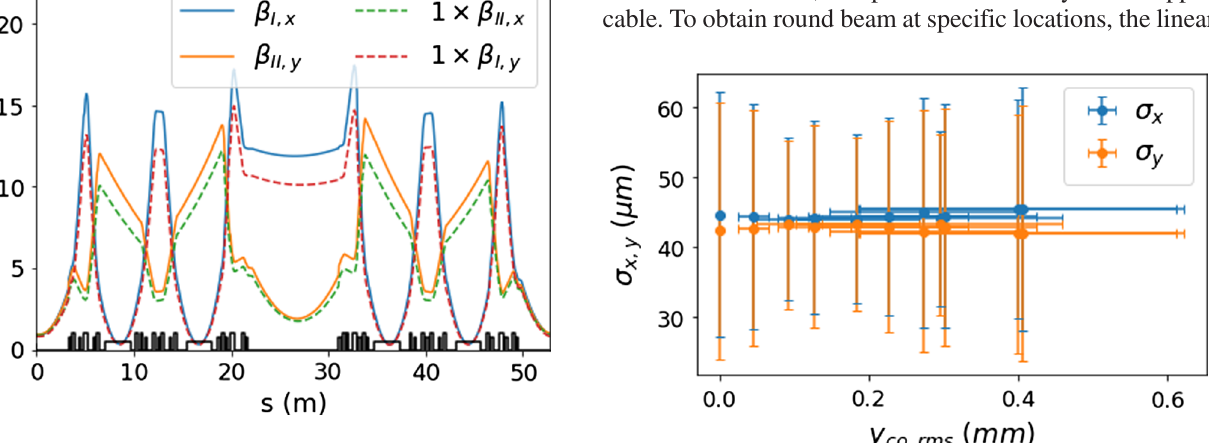
FIG. 9. On-resonance scheme: four coupled β functions of one supercell for one random seed with 500 μ rad quadrupole roll errors. The local β ð I;II Þ ;x at short straight sections are tuned close to β ð I;II Þ ;y , to obtain a geometric round beam there.